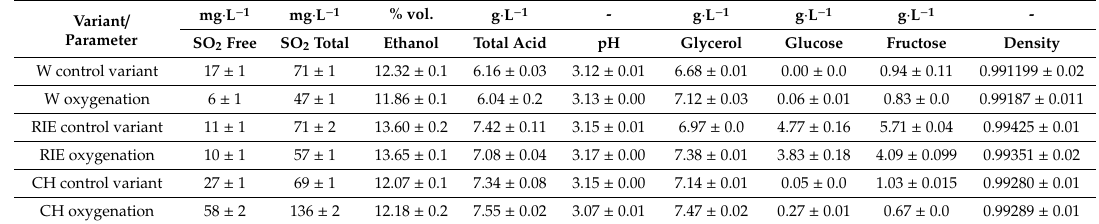
Table 2. Basic physicochemical parameters of wine from individual variants in 2015 with the standard deviations.